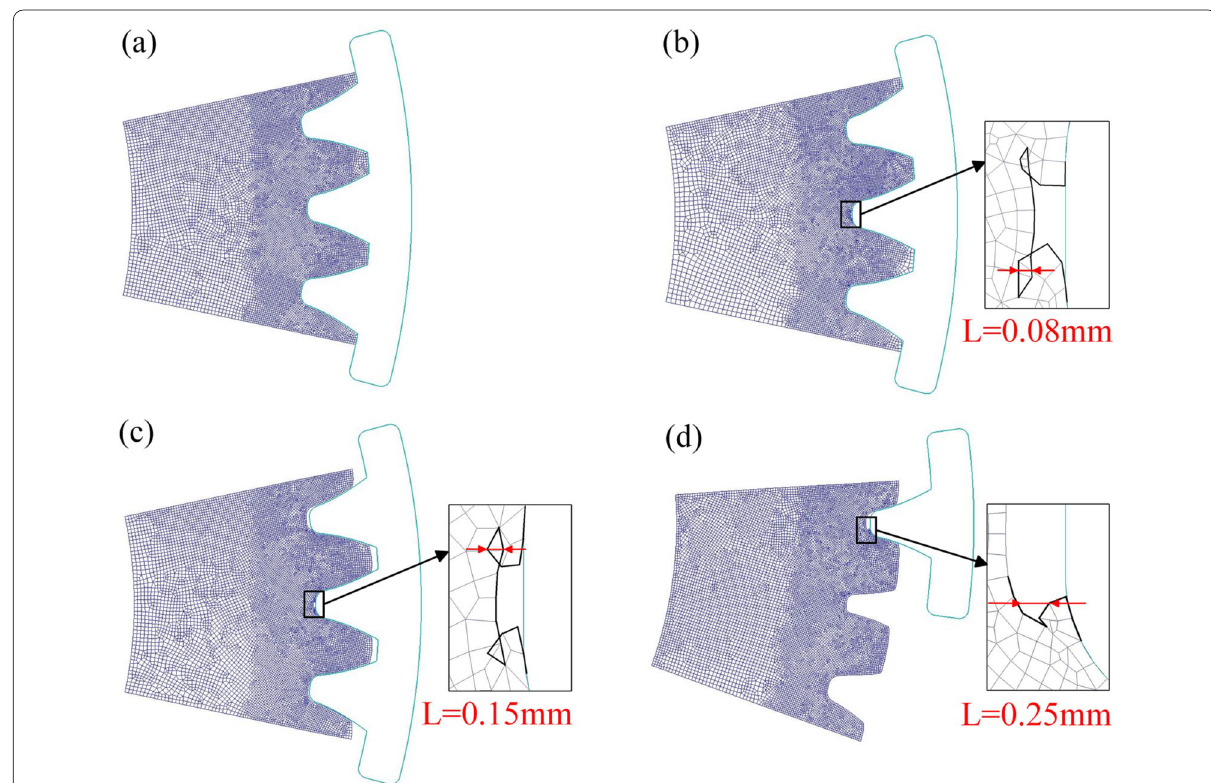
Figure 5 Simulation results of: (a) Scheme 2-1 (6 passes), accurate tooth shape without fold, (b) Scheme 2-2 (5 passes), severe fold in the finishing stage, (c) Scheme 2-3 (4 passes), severe fold in the finishing stage, (d) Scheme 2-4 (3 passes), severe fold in the third pass of preforming stage